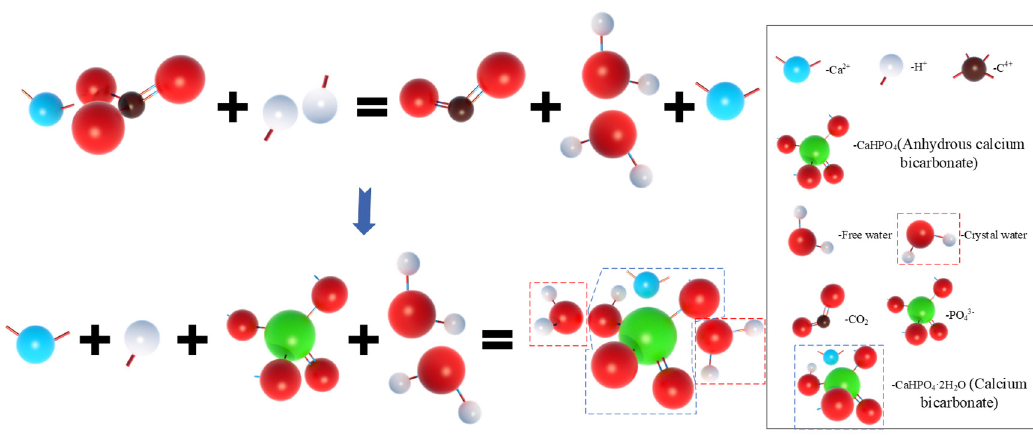
Figure 14. Reaction process of CaHPO 4 ·2H 2 O.